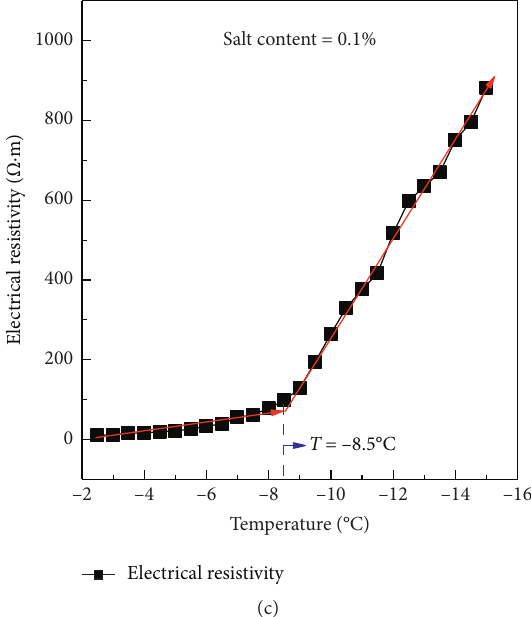
Figure 5: Electrical resistivity varies with temperature under a freezing state. (a) Without salinity. (b) Salinity of 0.2%. (c) Salinity of